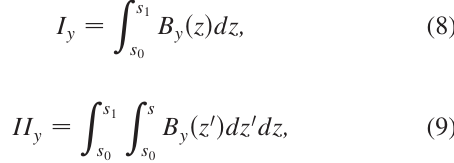
FIG. 8. Optimized end-coil radius r for Nb-Ti and Nb wiggler magnets with zero force in the end coil.